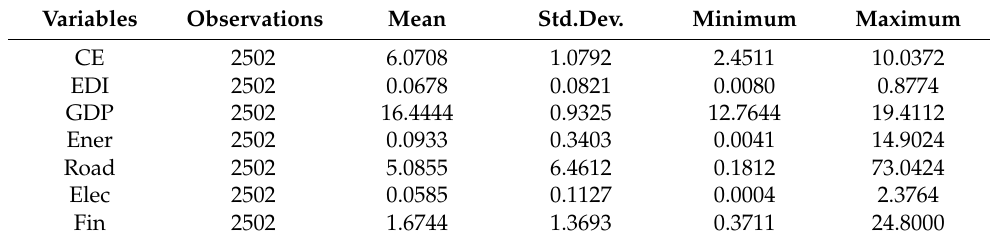
Table 2. Descriptive statistical results of main variables.